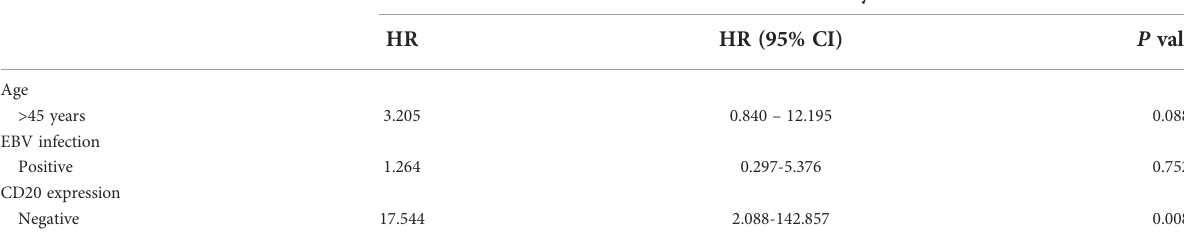
TABLE 2 Multivariate regression analysis for overall survival in NSCHL